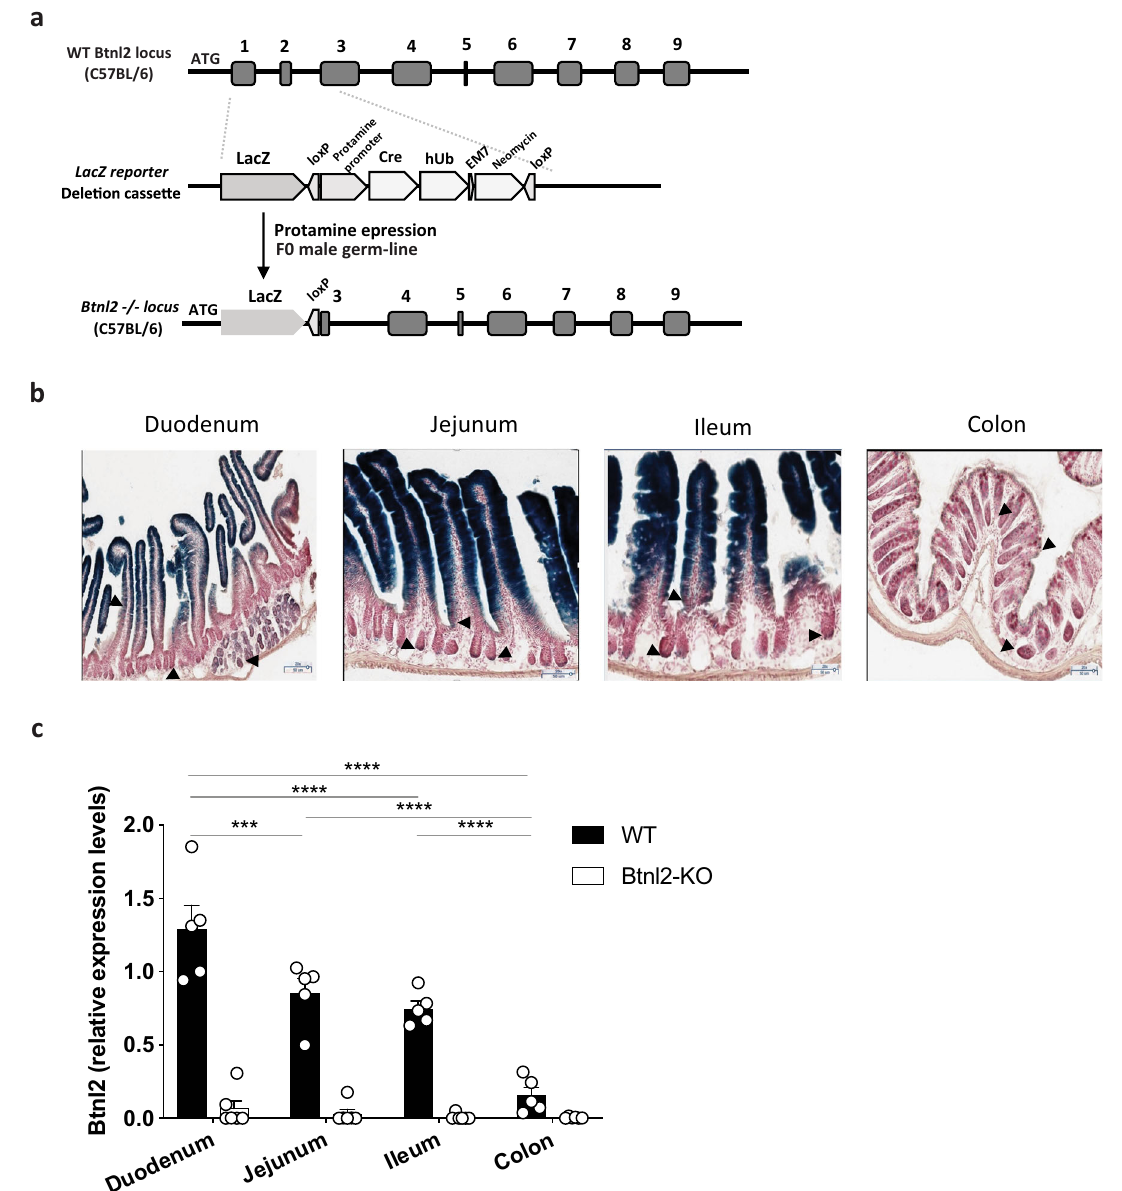
Fig. 1 Btnl2 is preferentially expressed in small intestinal epithelial cells. a Schematic representation of the WT and targeted locus of Btnl2 − / − mice. hUb, human Ubiquitin promoter. b Beta-galactosidase and Neutral Red counterstaining in cryosections of segments of the small intestine (duodenum, jejunum, and ileum) and colon of 15-week-old Btnl2-KO mice. Arrowheads indicate regions of duodenal glands and duodenal, jejunal, ileal, and colonic crypts and villi with weak Btnl2-LacZ expression. Magni fi cation is 20×; scale bar is 50 μ m. c mRNA expression of Btnl2 in intestinal epithelial cells from different segments of small intestine and colon of cohoused 7-week-old Btnl2-KO and WT mice ( n = 5, each), normalized to β 2m. Error bars represent mean ± SEM. Signi fi cance is measured using multiple unpaired t -tests assuming similar SD, * p < 0.05, ** p < 0.005, *** p < 0.0005, **** p < 0.0001, signi fi cantly different from WT